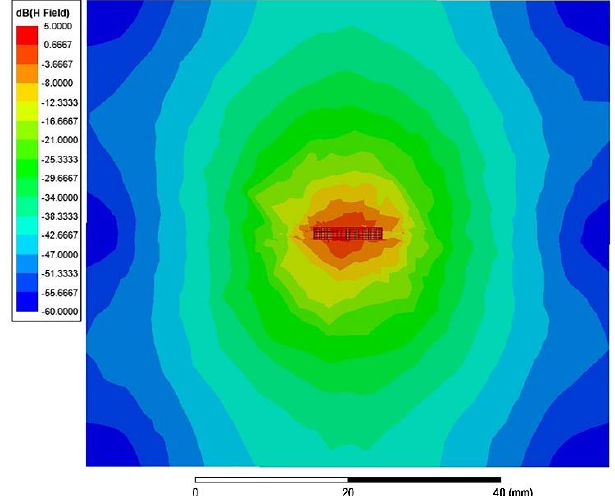
Figure 12. Simulation of the spatial magnetic field strength H in the XZ plane (orthogonal to the NFP-PCB).